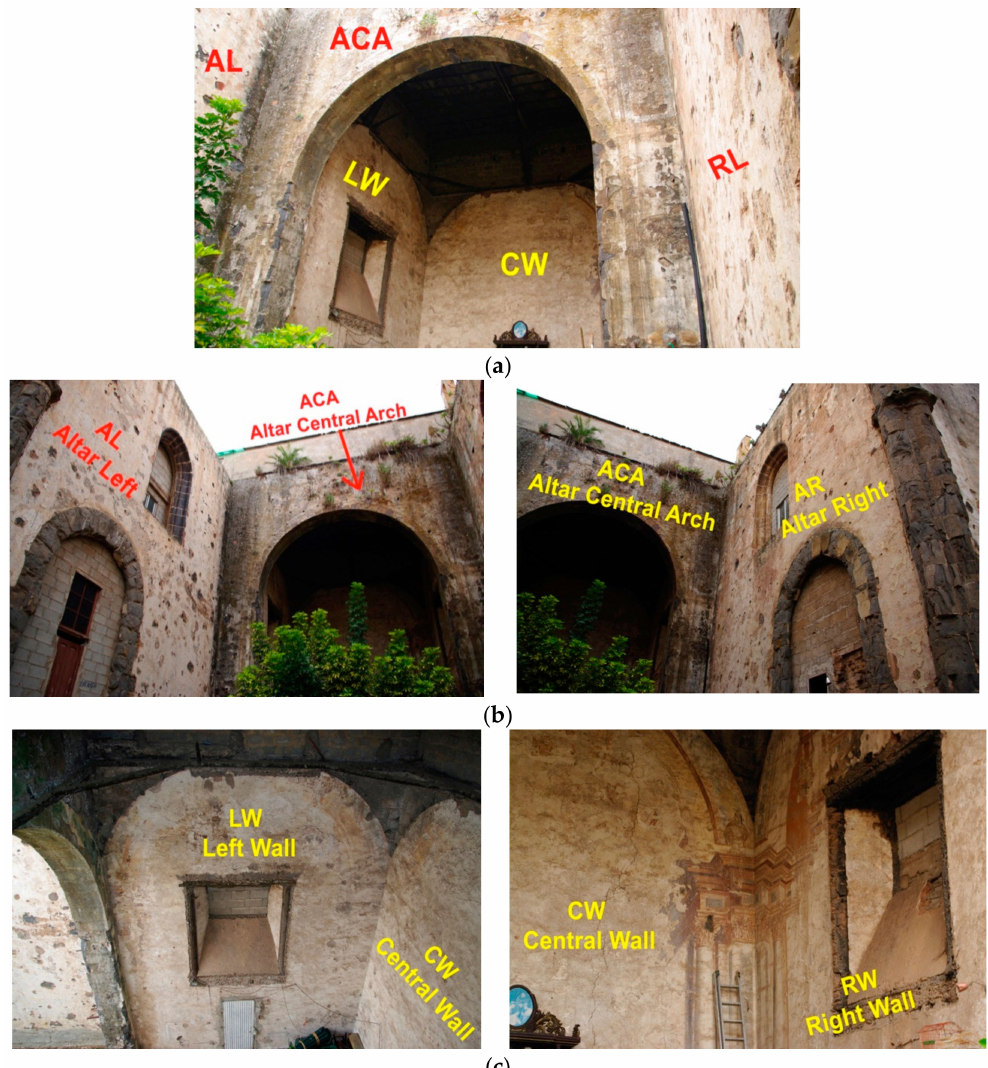
Figure 7. ( a ) Wide-angle shot of altar and presbytery, ( b ) First body—Altar: left facing (AL), right facing (AR) and central arch (ACA), ( c ) Second body—Presbytery: left facing (LW), central facing (CW) and right facing